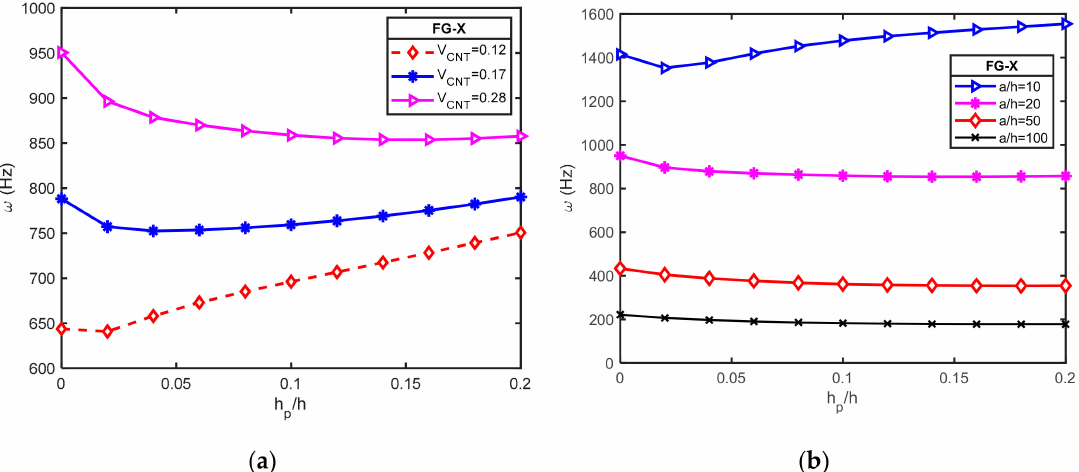
Figure 5. E ff ect of h p / h ratio on frequency parameter ω ( Hz ) of a square FG-CNTRC plate coupled with open circuit piezoelectric layer and di ff erent width-to-thickness ratio ( a = b = 0.4m; V * CNT = 0.28; [p / ( − 45 / 45) 3 / p]): (a) for di ff erent CNT volume fractions; (b) for di ff erent a / h